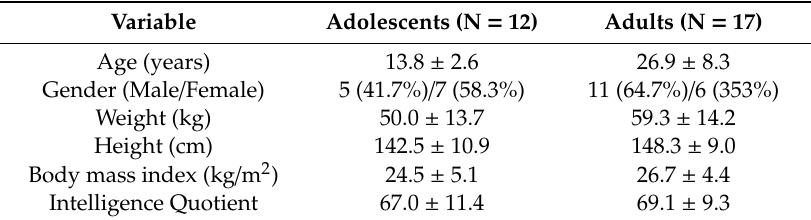
Table 2. Spatio-temporal gait parameters for adolescents and adults under the two walking conditions—walking barefoot (WB) and walking with shoes and FOs insoles (WSI).